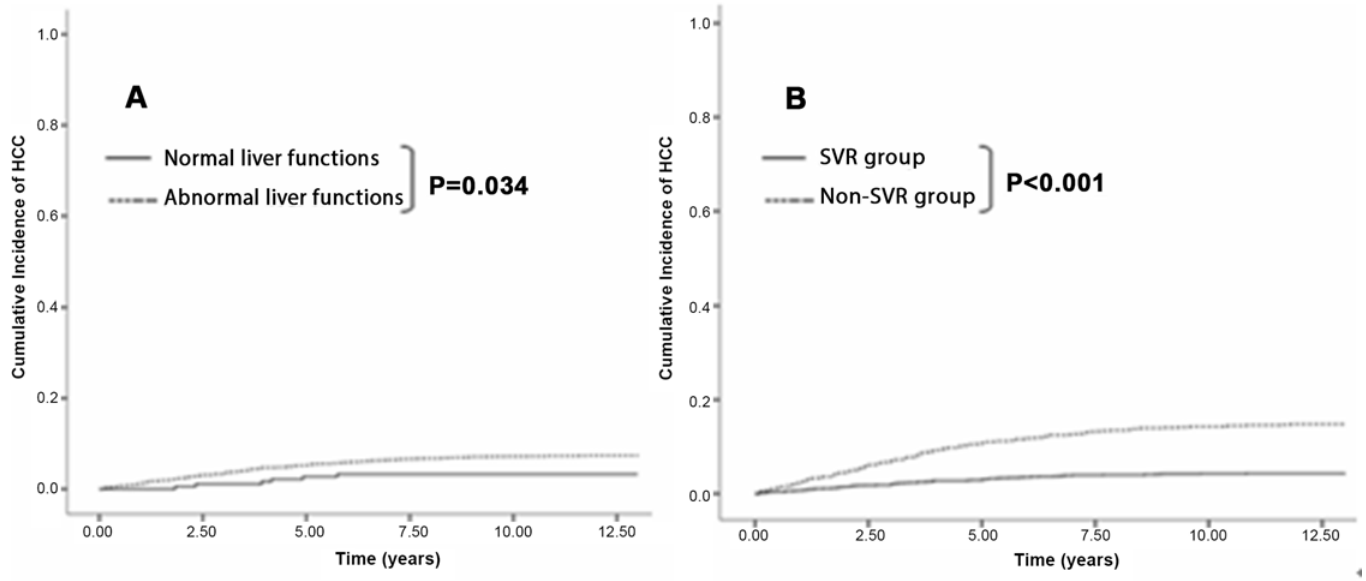
Fig 1. Cumulative Incidence of HCC development after IFN-based therapy. (A) Patients with abnormal liver functions had significantly higher incidence of HCC than those with normal liver functions (P = 0.034). (B) Patients who achieved sustained virological response (SVR) had significantly lower incidence of HCC than those who didn ’ t (P <